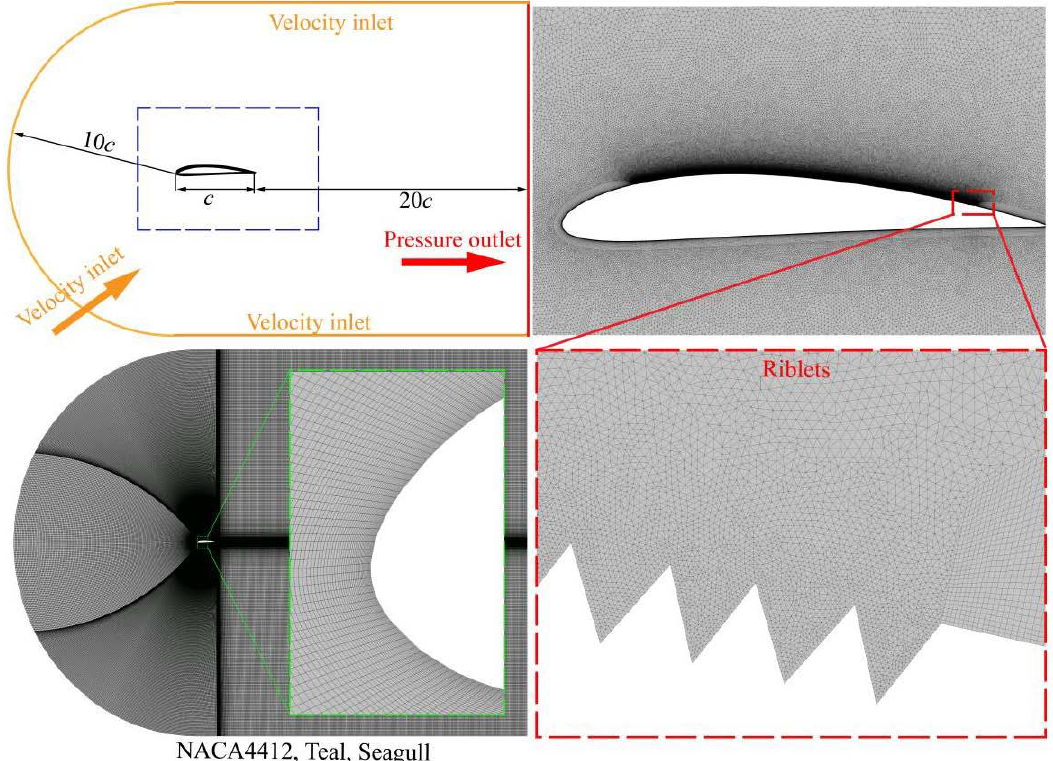
Figure 2. Computational Domains and Grids.